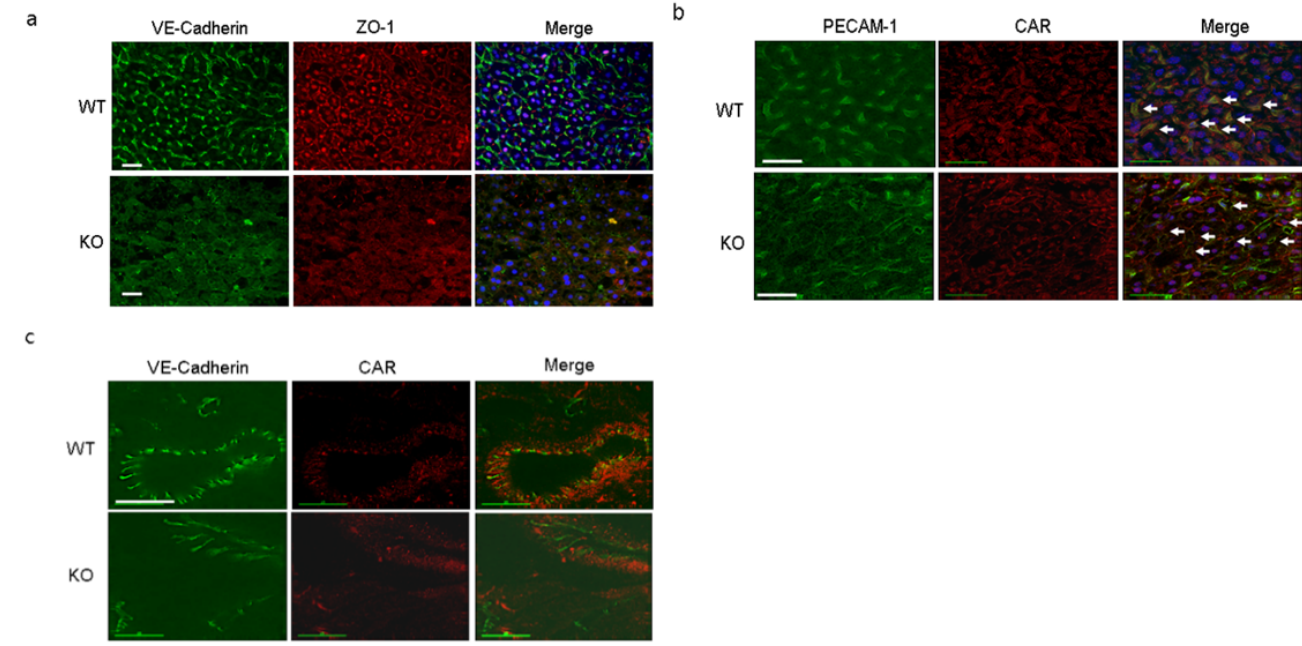
Figure 7. Disruption of the endothelial cell VE-cadherin and PECAM-1 expression by CAR ablation. ( a ). WT and KO mice liver were subjected to immunofluorescence staining using the indicated antibodies. Green, VE-cadherin and red, ZO-1. ( b ). Green, PECAM-1 and red, CAR in the vascular endothelial cells of liver, which are indicated by white arrows (scale bar, 40 µm and 15 µm). ( c ). WT and KO mouse hearts coronary vessel were subjected to immunofluorescence staining using the indicated antibodies. Green, VE-cadherin and red, CAR (scale bar, 15 µm).